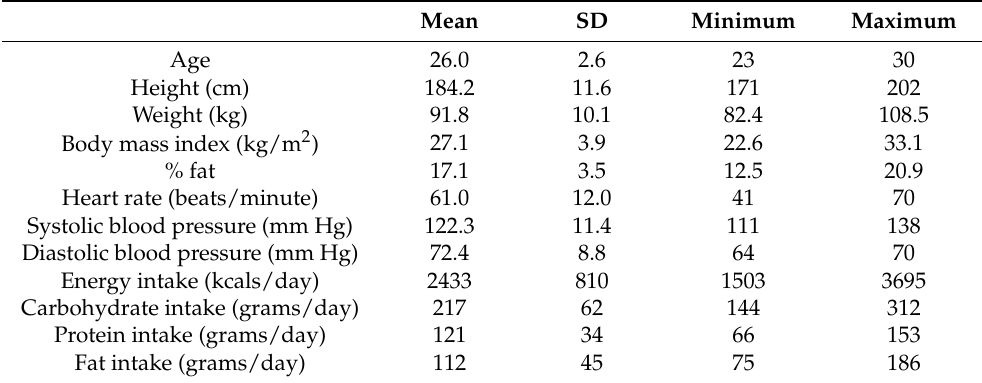
Table 1. Baseline age, gender, height (cm), weight (kg), body mass index, % fat, heart rate, systolic blood pressure, diastolic blood press, energy, carbohydrates, proteins, and fat intake. Mean